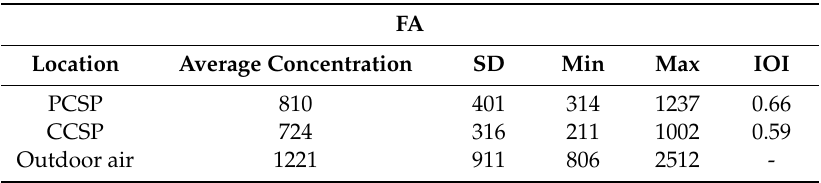
Table 2. Average concentration of fungal aerosol (FA) CFUs per cubic meter (CFU / m 3 ) and the IOI of the air inside and outside the sorting plant.